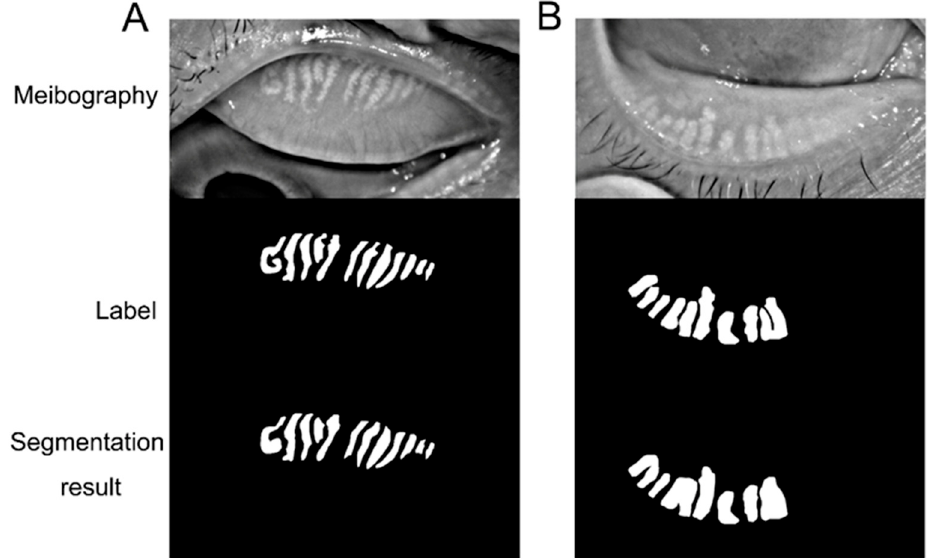
Figure 5. ( A ): The representatives of meibography, manual label, and segmentation results for upper and meibomian gland; ( B ): The representatives of meibography, manual label, and segmentation results for lower meibomian gland.